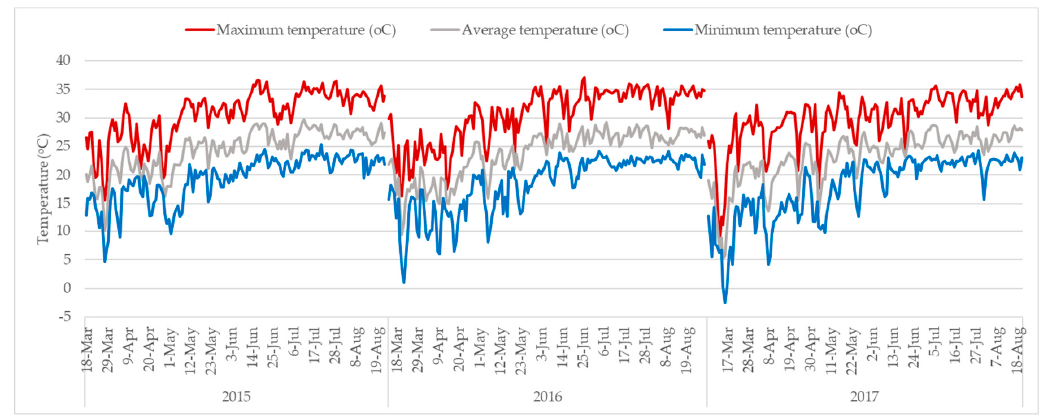
Figure 17. Maximum, minimum, and average temperatures (°C) in the area of Camilla, GA, where the SIRP field was located during the maize growing seasons of 2015, 2016, and 2017.